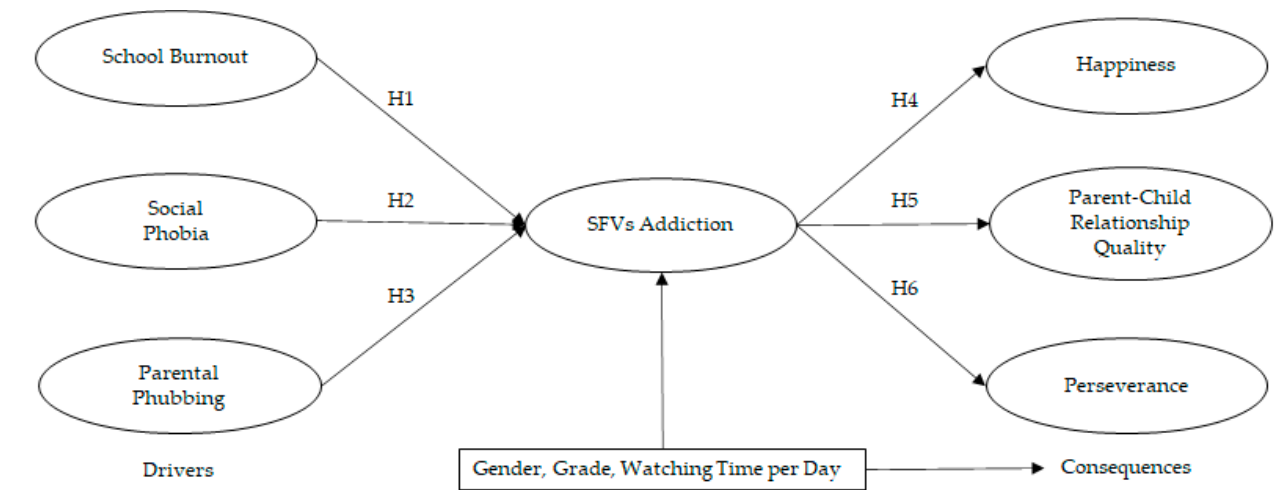
Figure 1. The research